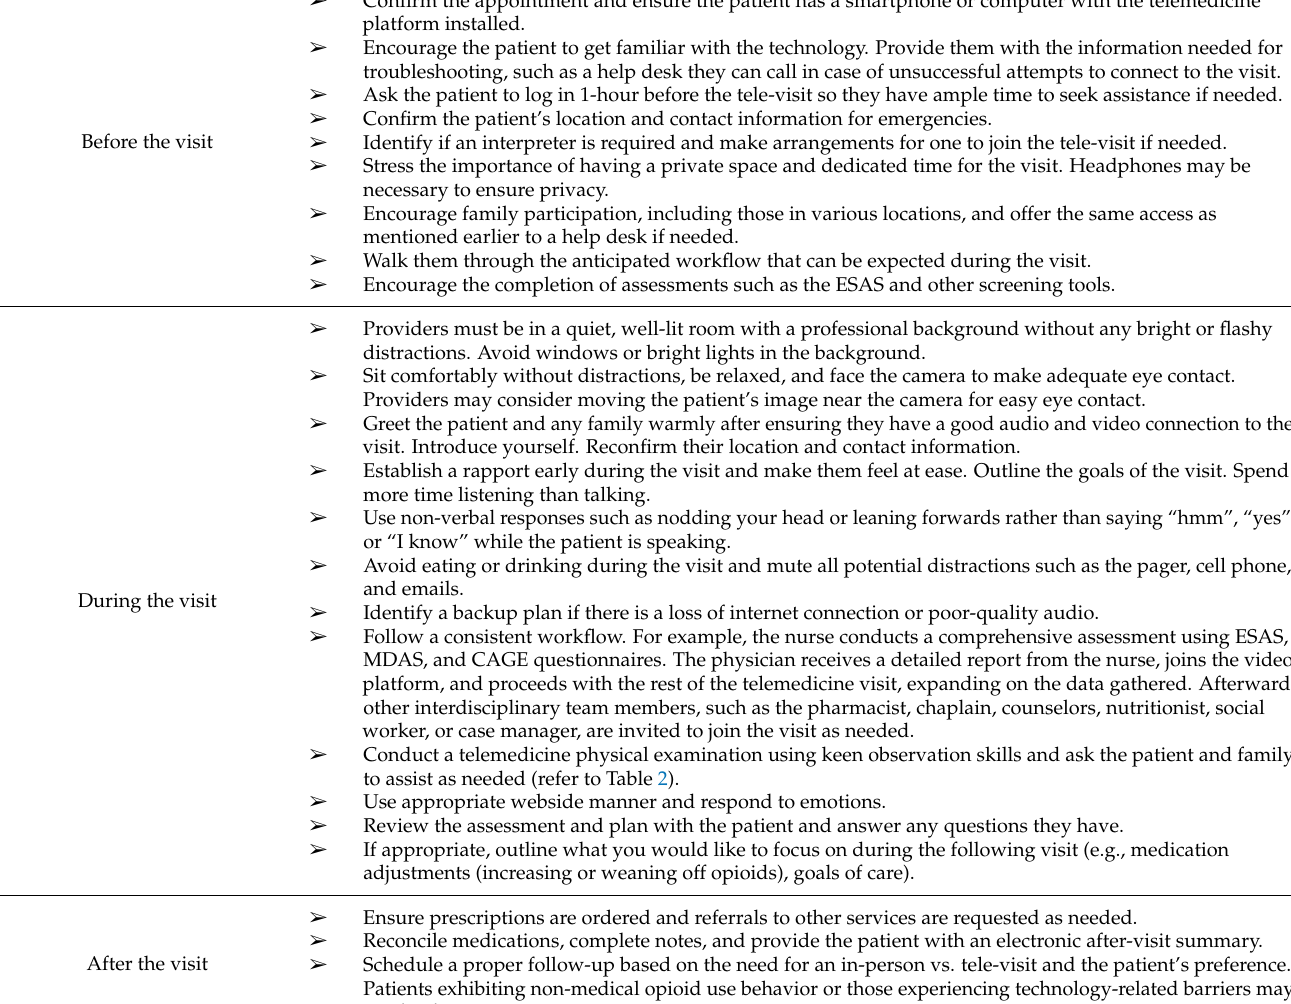
Table 1. Best Practices for Telemedicine in Palliative